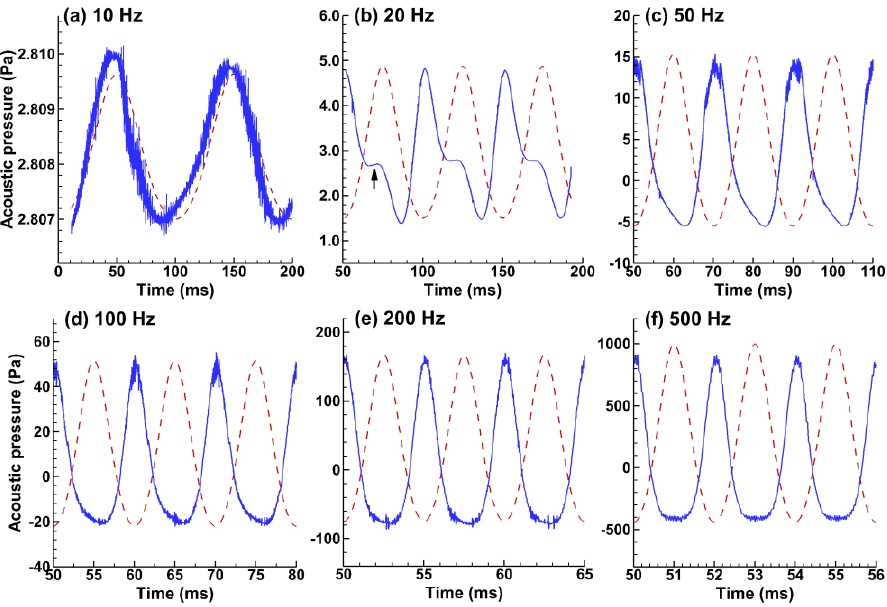
Figure 7. Pressure signals (blue line) at 0.3 m from the mouth opening computed using the FW-H model: ( a ) 10 Hz, ( b ) 20 Hz, ( c ) 50 Hz, ( d ) 100 Hz, ( e ) 200 Hz, and ( f ) 500 Hz. The red line is the sinusoidal motion of the glottis.